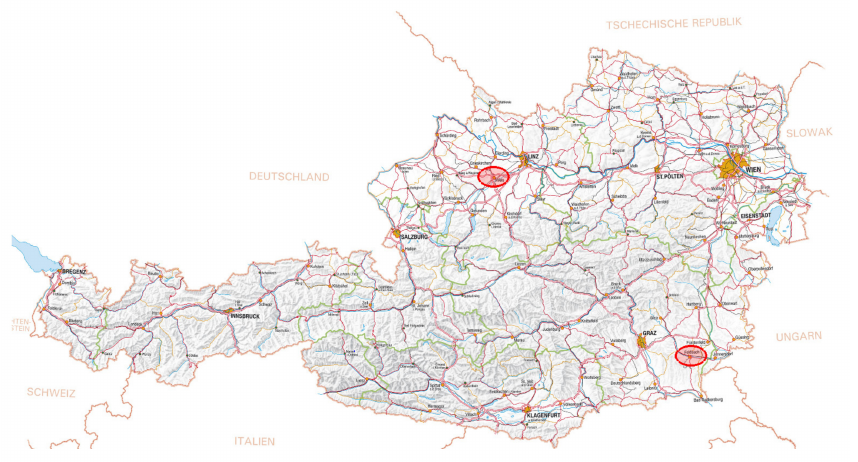
Figure 1. Map of Austria showing the two focus regions (red areas) Wels (in the north) and Feldbach (in the